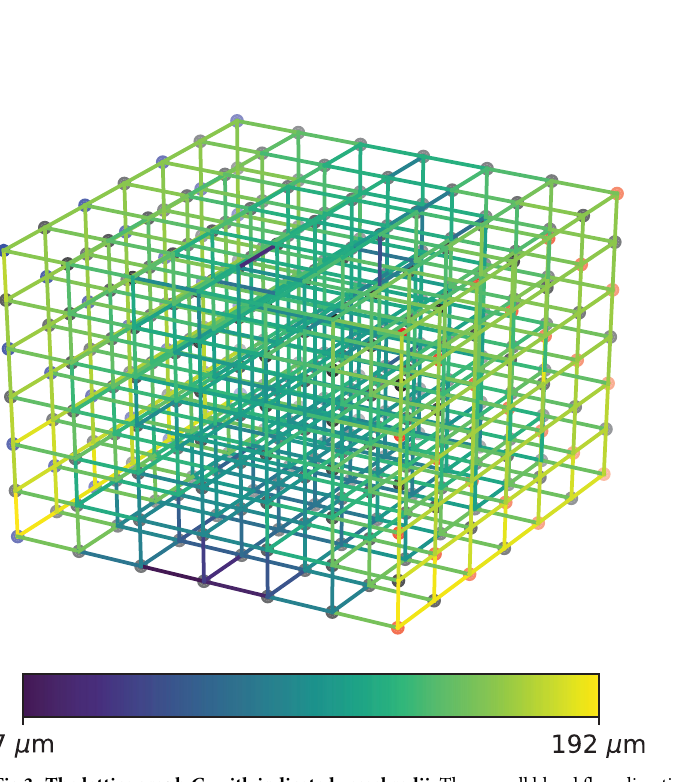
Fig 3. The lattice graph G 6 with indicated vessel radii. The overall blood flow direction is from left to right.